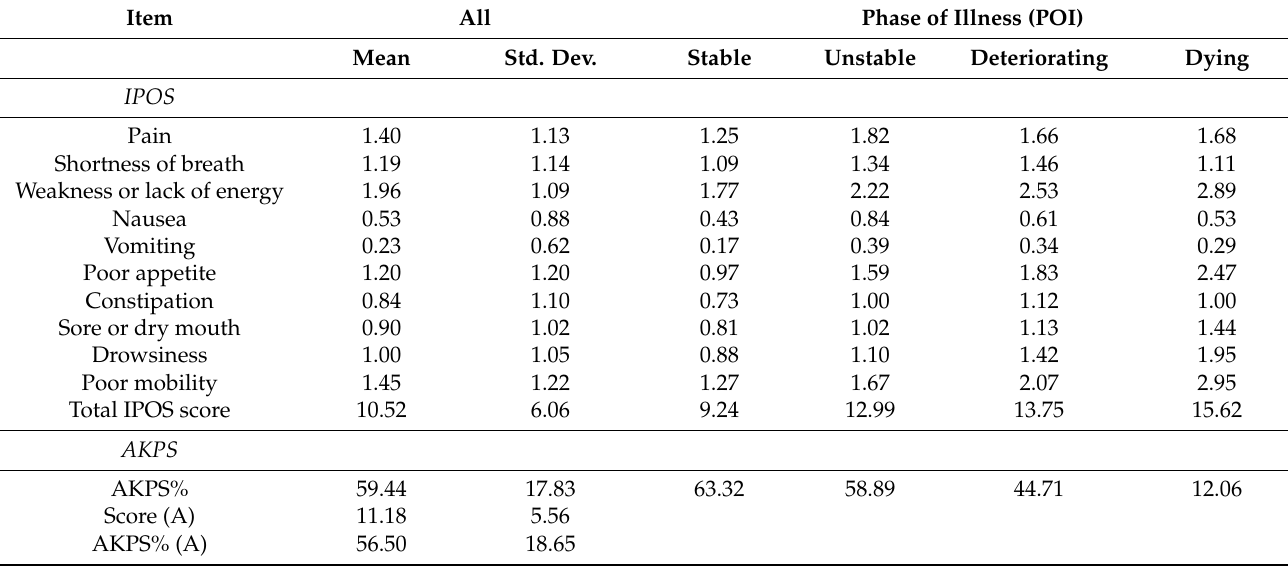
Table 3. Descriptive statistics for the AKPS, IPOS, and